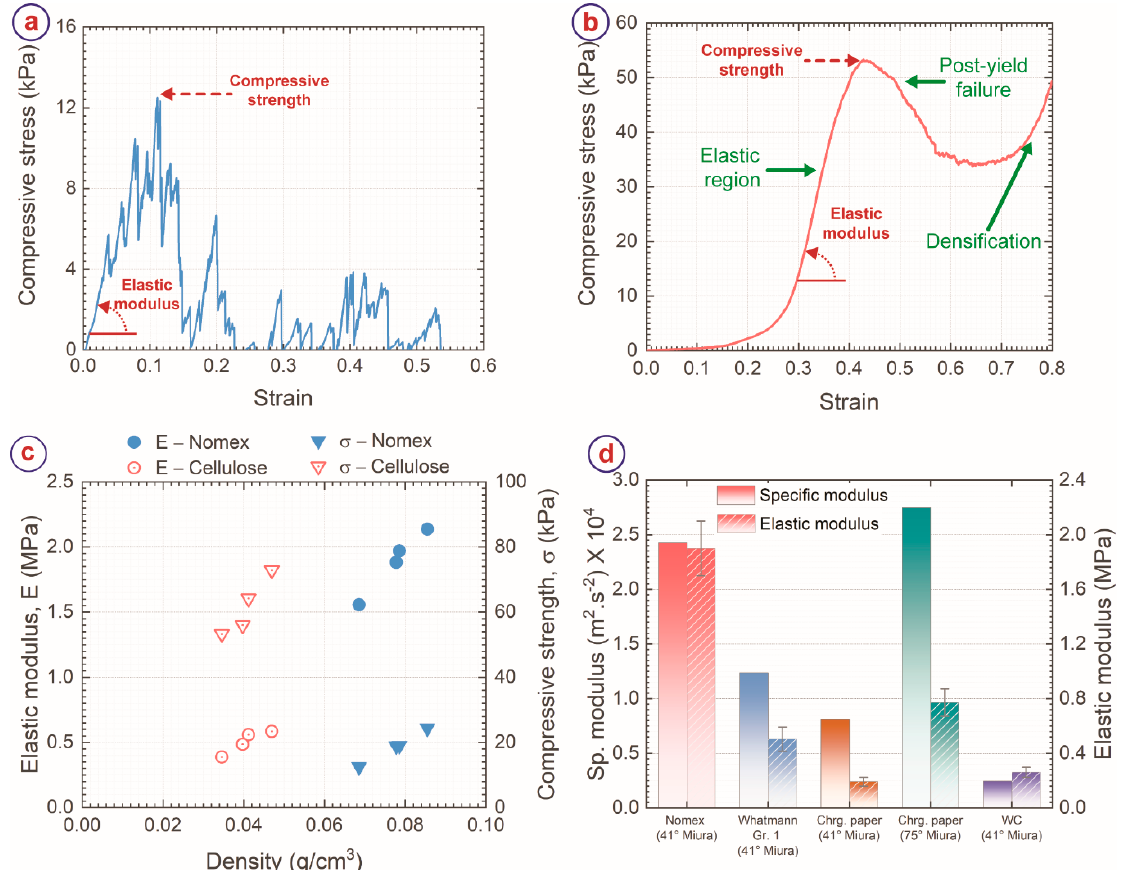
Figure 5. Stress–strain curve of ( a ) Nomex-derived carbon Miura-ori and ( b ) cellulose-derived carbon Miura-ori under a compressive load. The point of compression strength ( σ ) and definition of elastic modulus (E) were indicated in both the carbon samples. ( c ) Comparison of E and σ of the carbon Miura-ori samples against their structural density. ( d ) Comparison of E and specific modulus of different carbonaceous Miura-ori obtained from different precursor sheets. The data for chromatography (Chrg.) paper and WC were obtained from Ref. [18] and [16], respectively.